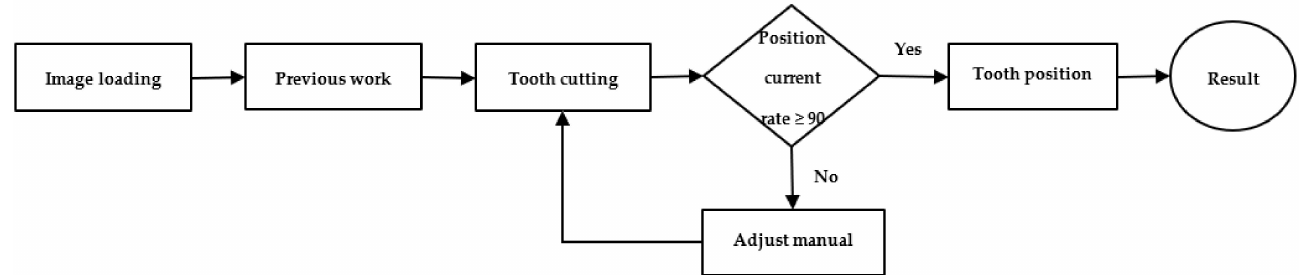
Figure 1. The general flow chart of the proposed tooth-detection method.